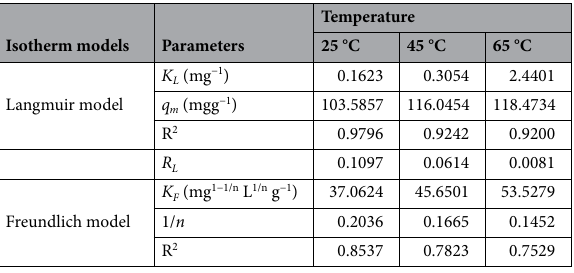
Table 3. Fitting parameters for the adsorption isotherm models of